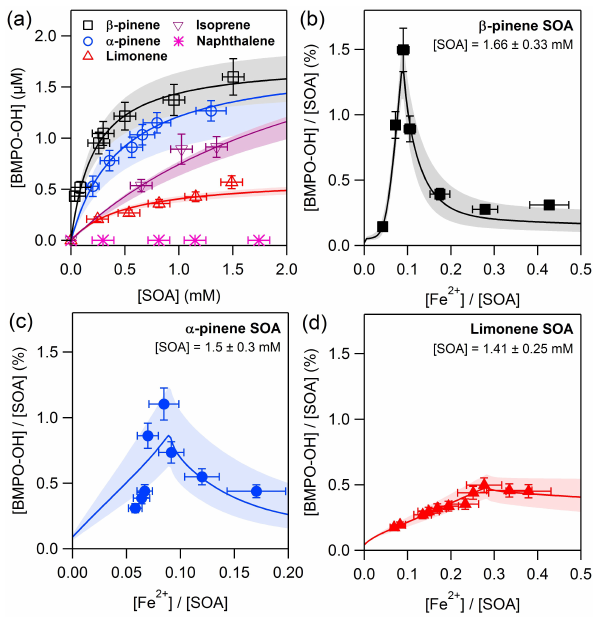
Figure 4. OH formation efficiency by SOA. (a) Concentrations of OH radicals formed in water extracts of SOA of β -pinene (black), α -pinene (blue), limonene (red), isoprene (purple) and naphthalene (pink) as a function of SOA concentrations in the aqueous phase. The formation efficiency of OH (molar concentration ratio of OH to SOA: [BMPO-OH] / [SOA], in %) in iron containing SOA wa- ter extracts against molar concentration ratios of FeSO 4 and SOA ([Fe 2 + ] / [SOA]) by (b) β -pinene, (c) α -pinene and (d) limonene. The markers are experimental data, and the solid curves with shaded area are modelled with uncertainty.